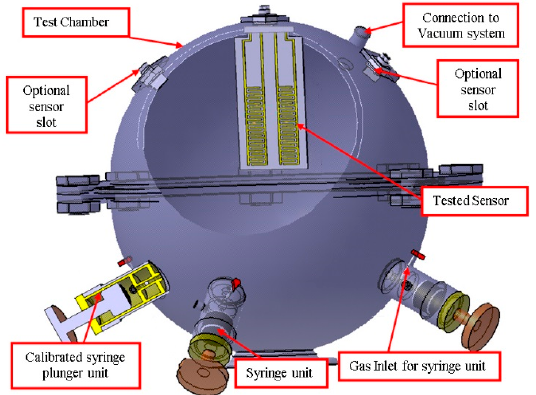
Figure 2. Arrangement of the necessary elements to perform the measurements.